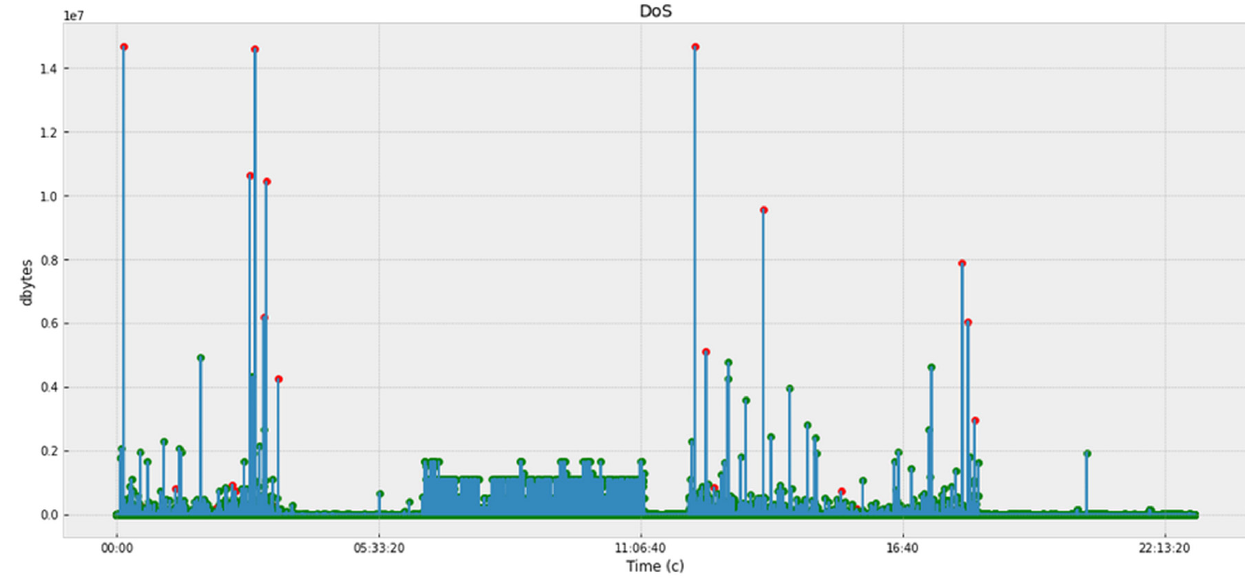
Figure 23. DDoS attack.